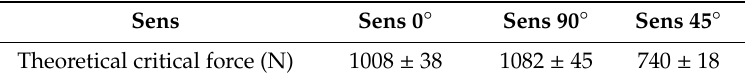
Table 2. Theoretical values of critical force.